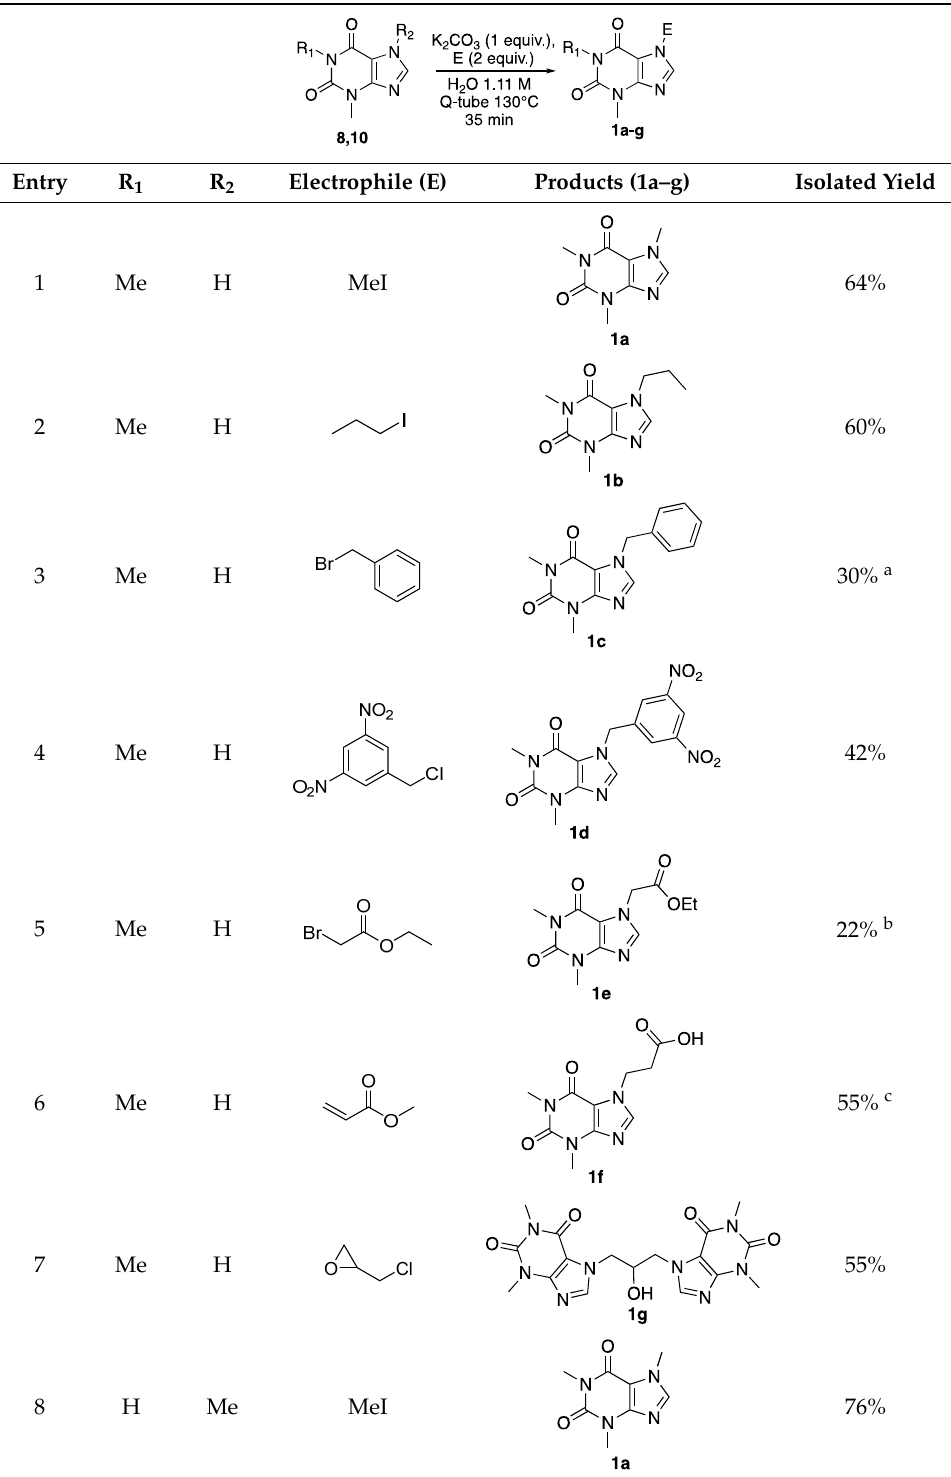
Table 2. Synthesis of caffeine analogues.